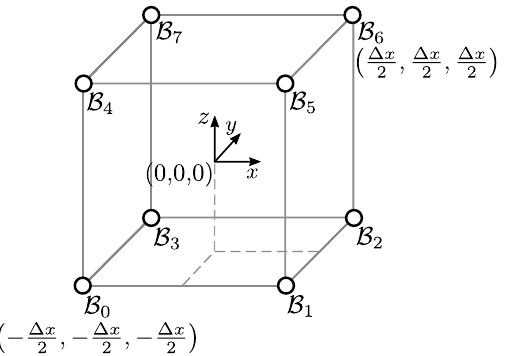
Figure A1. Base point nomenclature for compact gradient-based velocity